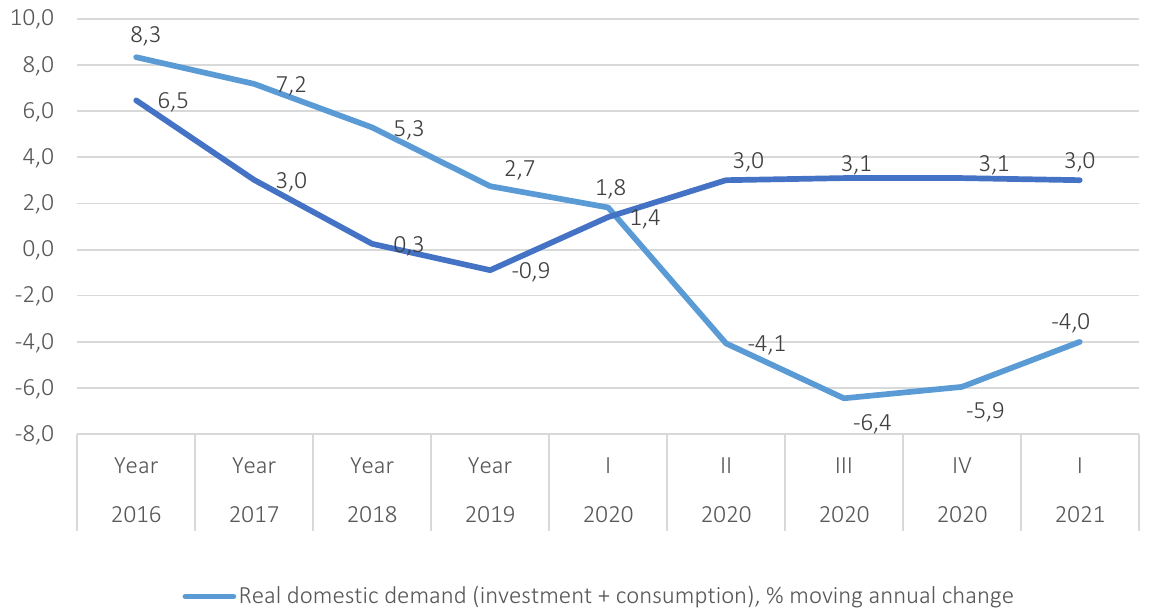
Figure 1. Neutral interest rate and domestic demand in